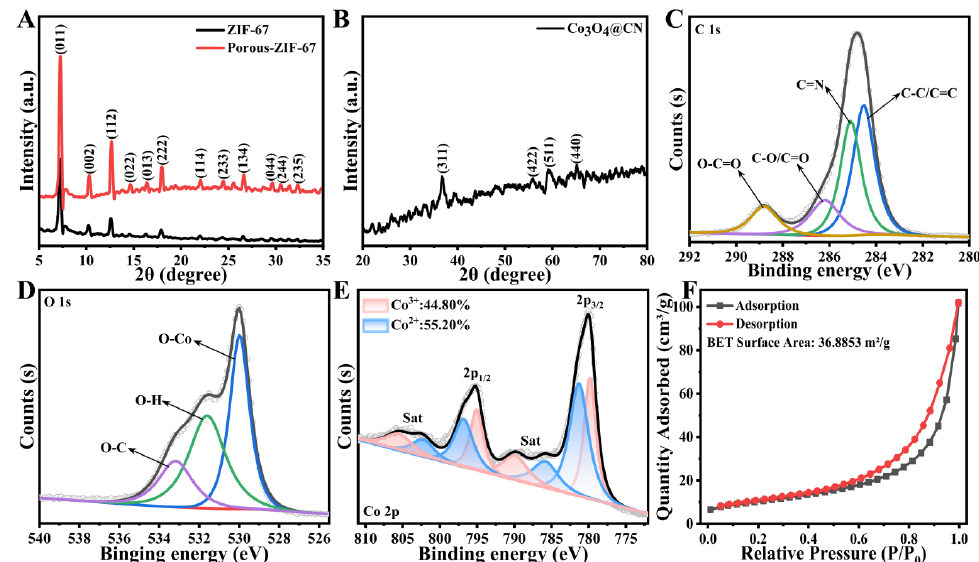
Figure 2. The XRD spectra of ( A ) ZIF-67 and Porous-ZIF-67 and ( B ) Co 3 O 4 @CN. High-resolution XPS spectra of ( C ) C 1s, ( D ) O1s and ( E ) Co of Co 3 O 4 @CN. ( F ) The N 2 adsorption-desorption isotherm line of Co 3 O 4 @CN.